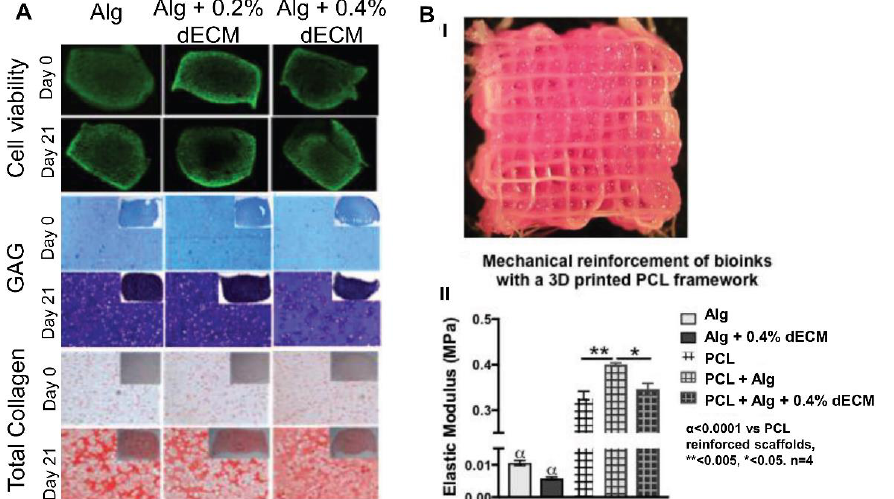
Figure 6. Alginate/dECM-based scaffolds: ( A ). Cell viability, histology, and immunostaining on days 0 and 21 showed good cell viability and high GAG and collagen production within 21 days. ( B ) Alginate/dECM 3D bioprinting and PCL 3D printing combination. ( I ) Representative image of the hybrid scaffold. ( II ) Mechanical properties are enhanced with PCL reinforcement.